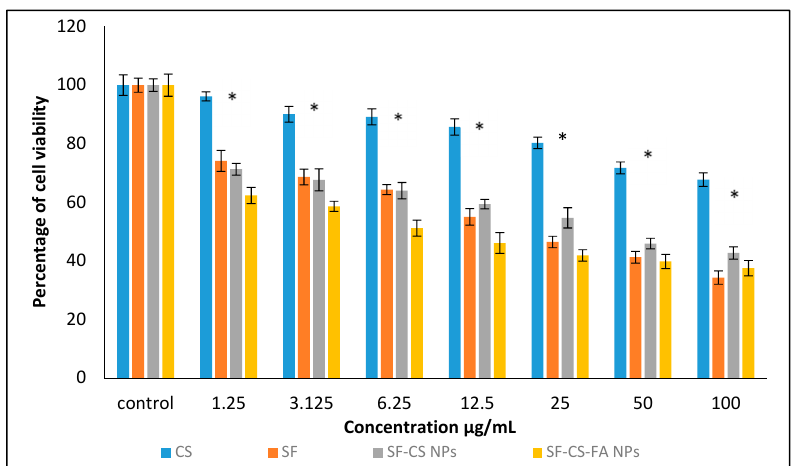
Figure 14. Cytotoxicity assay of CS, SF, SF-CS, and SF-CS-FA nanoparticles against HepG2 cells at 72 h of incubation. Values are expressed as mean ± SD of triplicates. The significant differences ( p < 0.05) * were determined using the one-way ANOVA followed by Duncan’s Multiple Range Test.